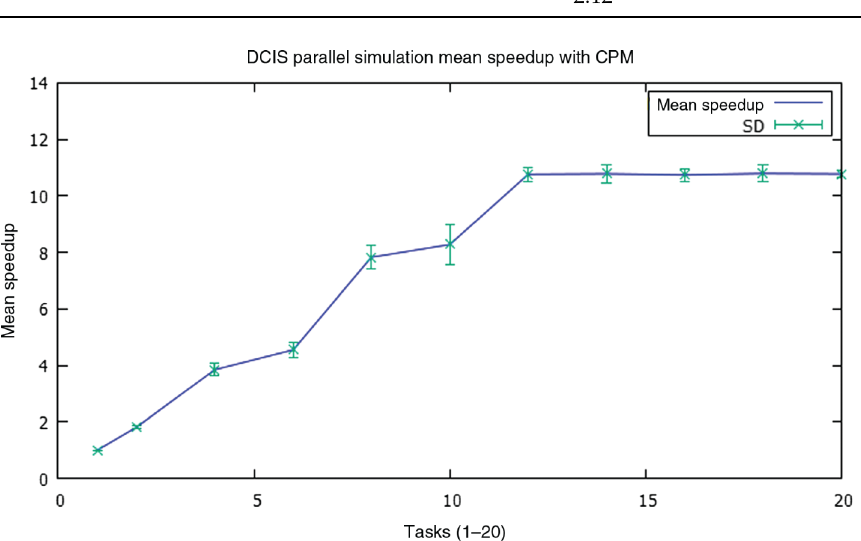
Figure 9: Average speedups for an increasing number of parallel threads, obtained by averaging the result of running the simulation with the same initial conditions in eight different nodes of the